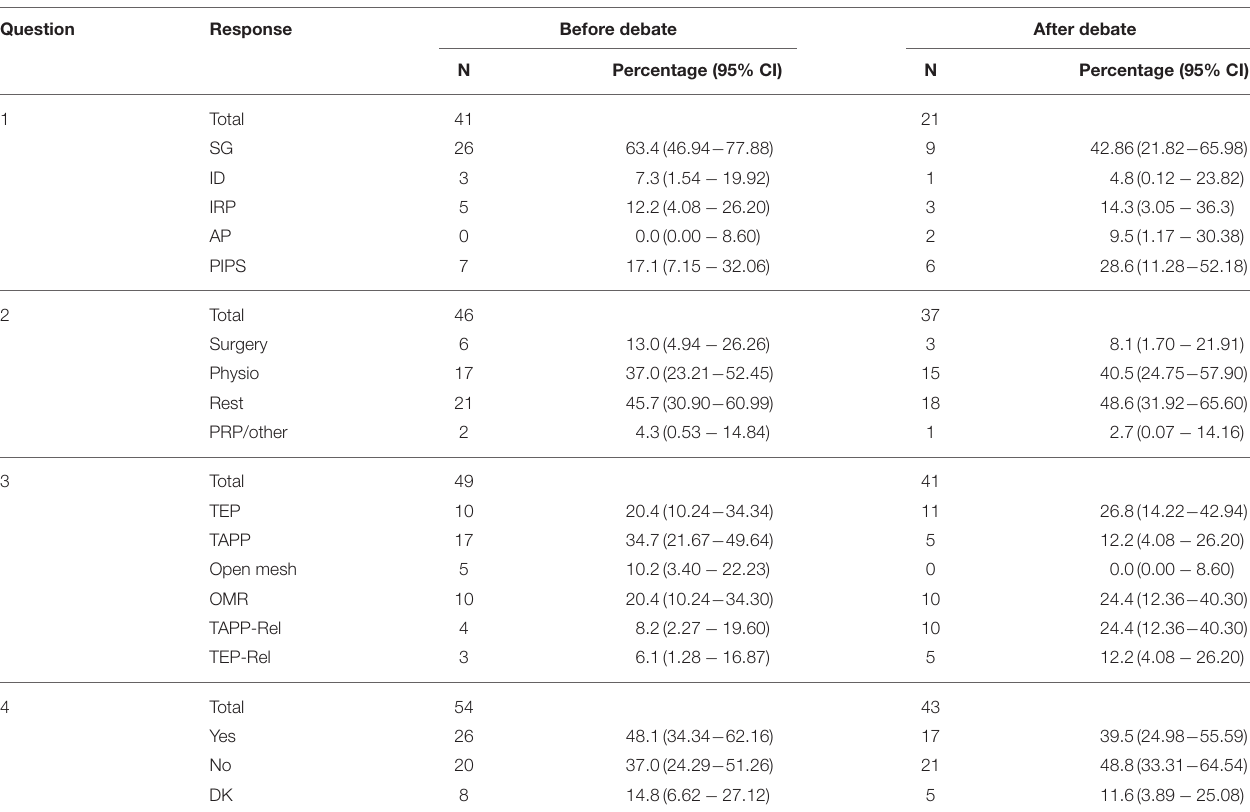
TABLE 1 | A summary of debate questions before and after presentations and debate.